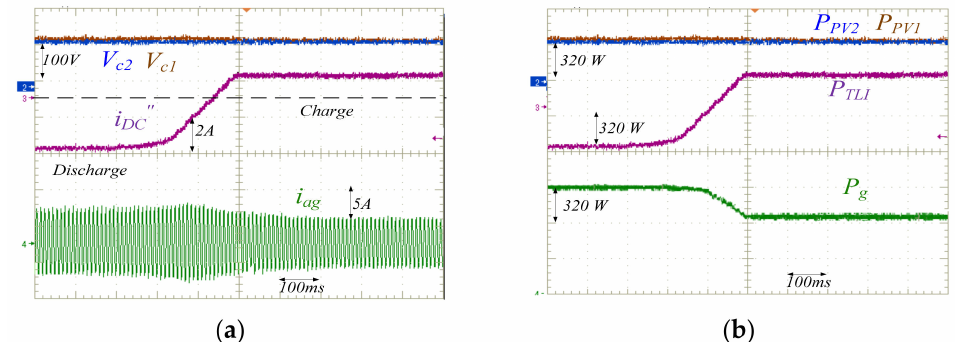
Figure 17. The (3LI + TLI) battery current variation from 2 A to − 2A with G PV 1 (cid:54) = G PV 2 . ( a ) String voltages V c 1 and V c 2 . Battery current i DC (cid:48)(cid:48) . Grid current i gj ( b ) String power P V 1 , P V 2 . Battery power P Batt , grid active power P g .